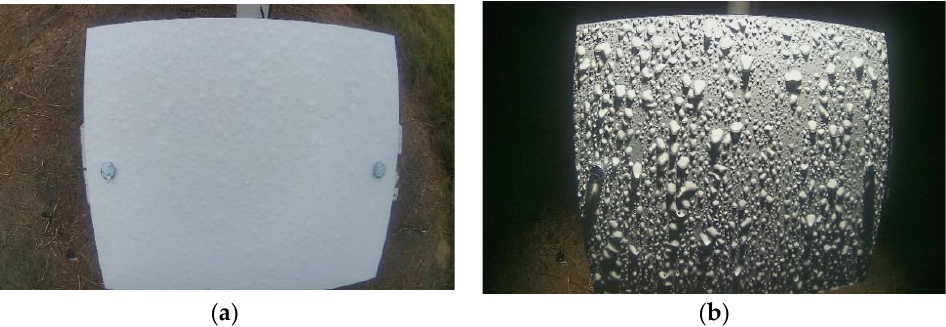
Figure 5. Example images of the reference surface: ( a ) color image acquired during normal daylight conditions and ( b ) color image acquired during the nighttime with the help of artificial illumination.